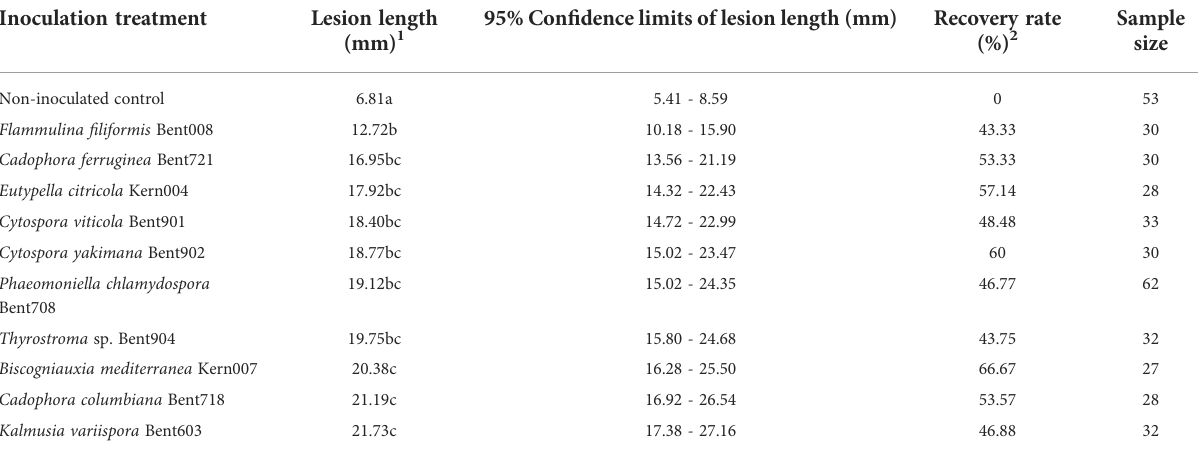
TABLE 2 Mean lesion lengths and recovery rates of ten fungal isolates from the woody stems of Vitis vinifera ‘ Chardonnay ’ at 12 months post- inoculations in duplicated greenhouse experiments. Inoculation